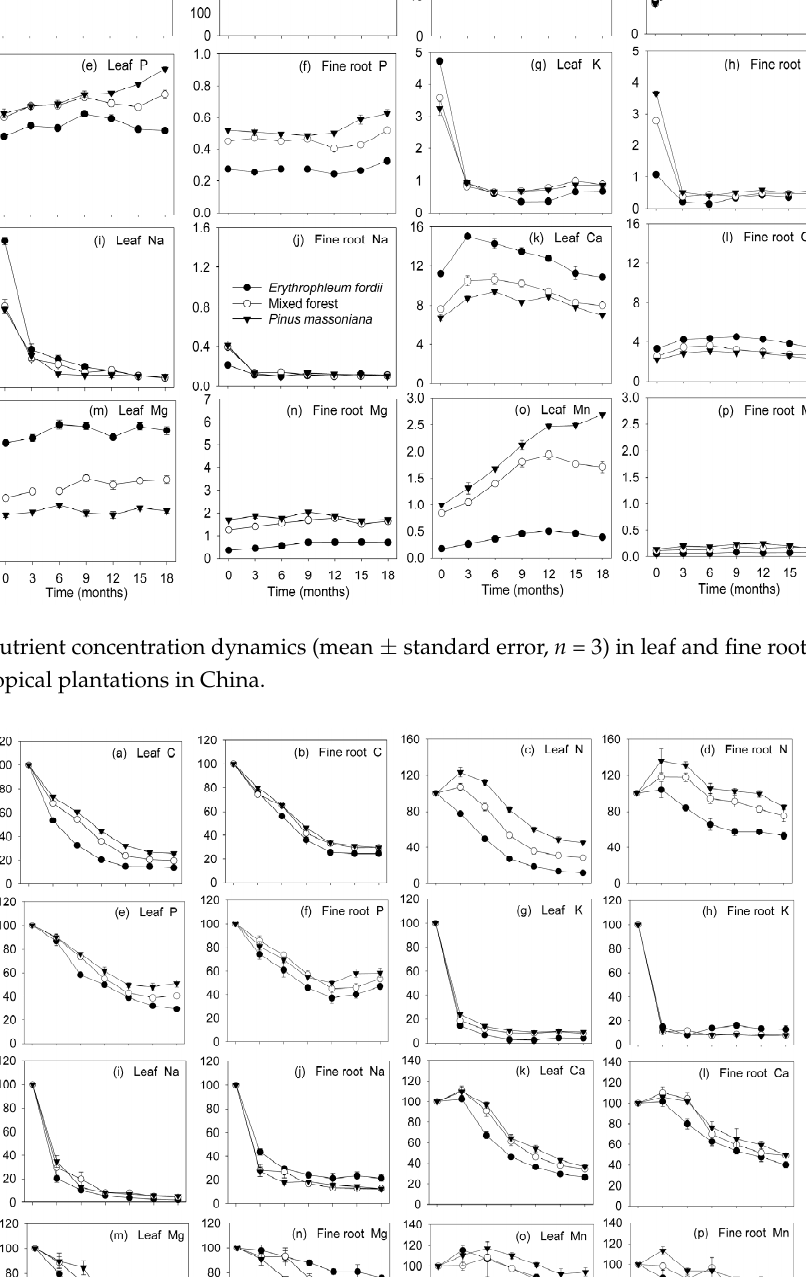
Figure 5. Dynamics of C/N, C/P, N/P, and lignin/N ratios (mean ± standard error, n = 3) in leaf and fine root litter of three subtropical plantations in China.